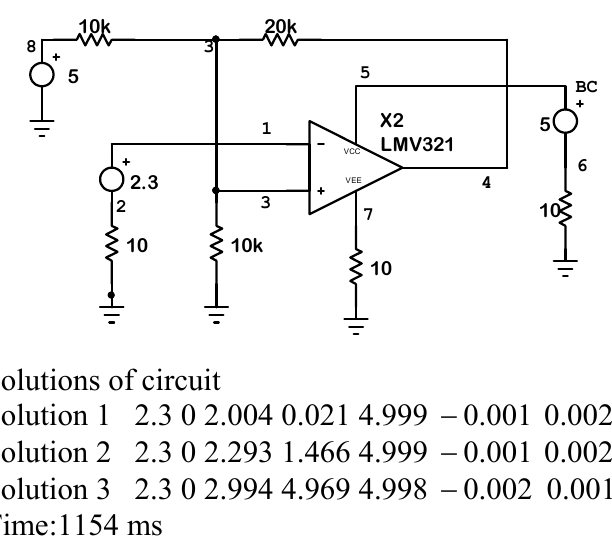
Figure 7. A circuit containing an operational amplifier LMV321 modeled using the default IsSpice macromodel and DC solutions found by the proposed method.